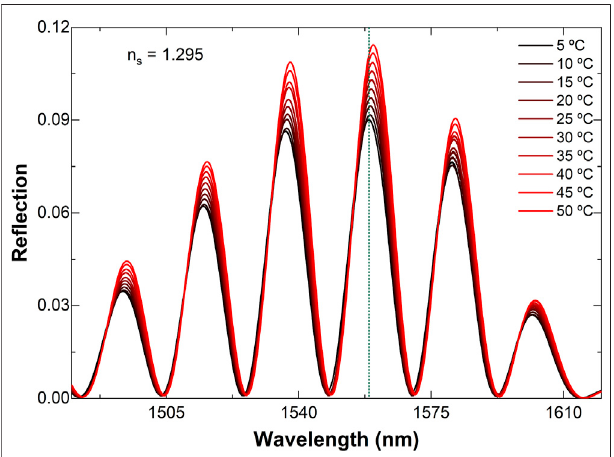
FIGURE 4 | Interference patterns observed when the MCF interferometer immersed in a liquid with an index of 1.295 was exposed to different temperatures. The dotted vertical line is to show the shift of the interference